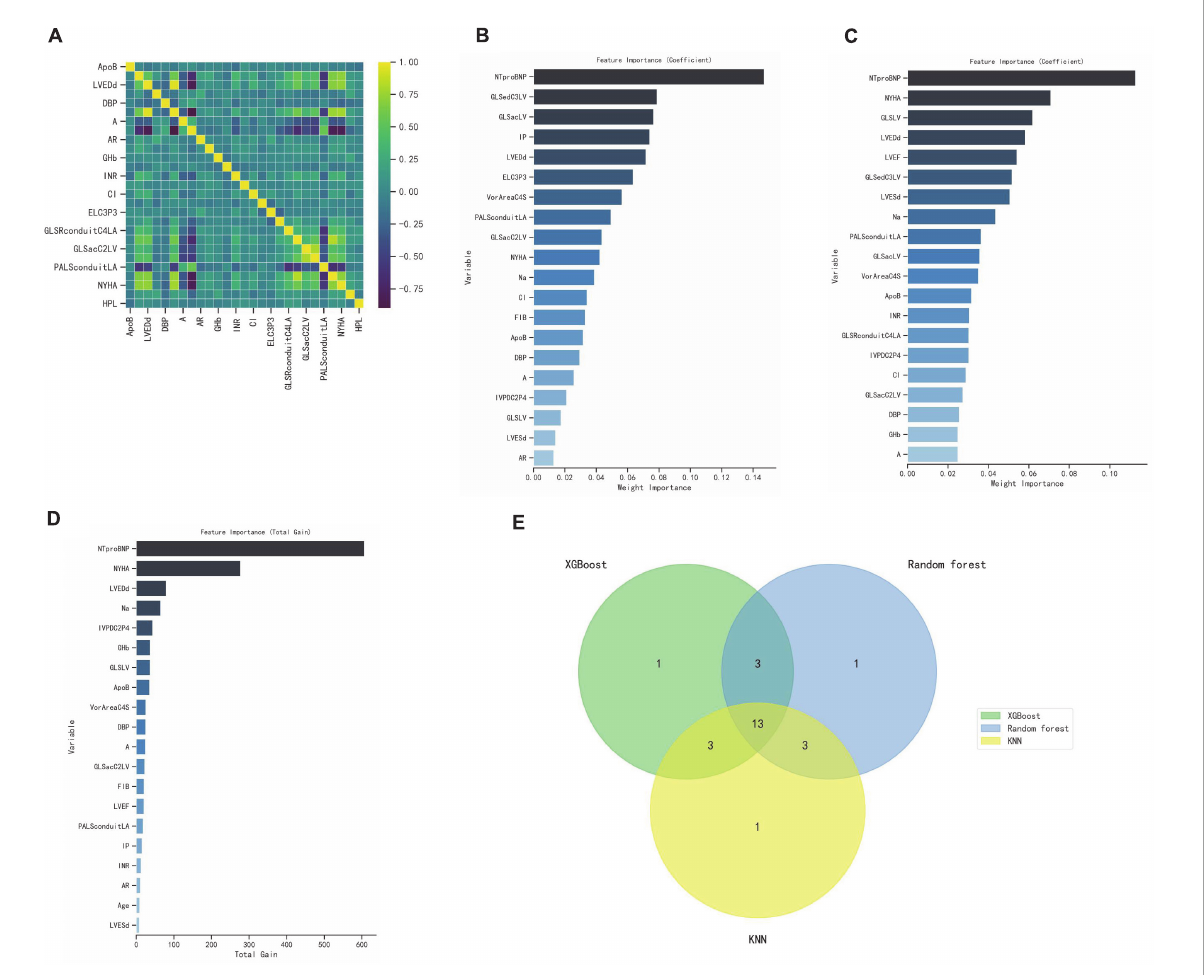
FIGURE4 Select optimal prognostic variables. (A) Correlation heatmap showing associations between clinical features and ultrasound parameters. (B–D) XGBoost, Random forest, KNN calculate the importance of each influencing factor to the classification model and rank it, the top 20 parameters were selected. (E) Venn diagram, 13 variables were